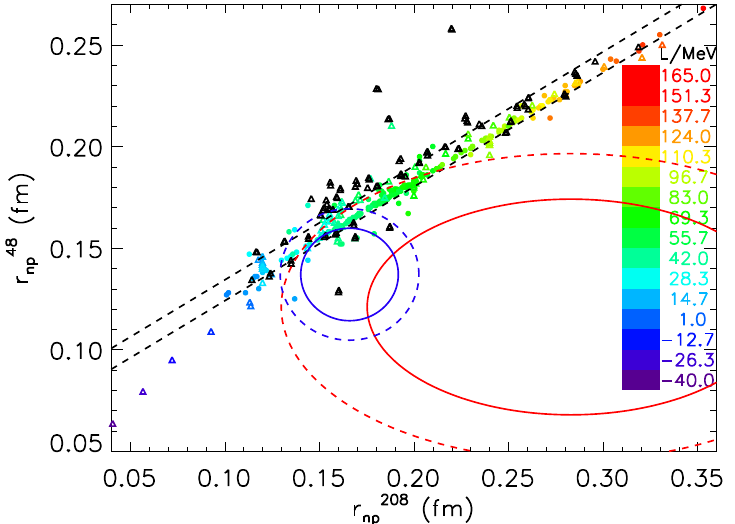
Figure 9. Neutron skin thicknesses of 48 Ca and 208 Pb from interactions compiled in Ref. [37] (filled circles) and Refs. [18,60,63,64] (triangles). Colors indicate L values where known; black triangles indi- cate points where L values are unspecified. Standard deviations of a linear correlation Equation (21) are shown as dashed lines. The red (blue) confidence ellipses are from PREX I+II [17] and CREX [18] (mean of all experiments); solid (dashed) ellipses are 68% (90%)